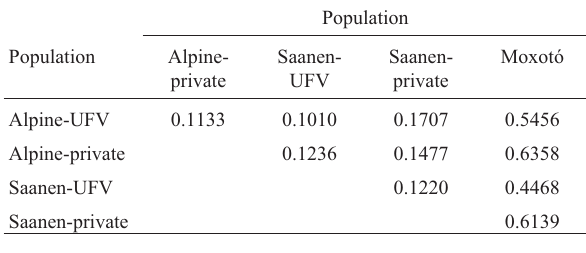
Table 5 - Nei’s genetic distance between the populations